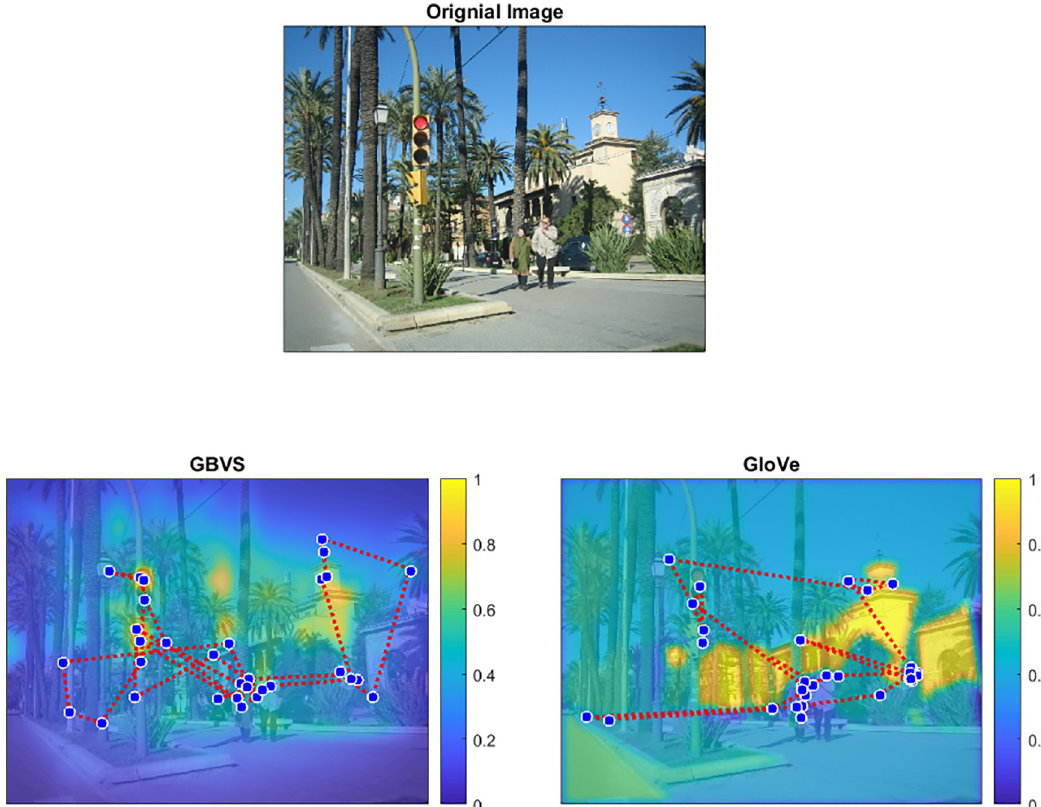
Fig 2. Examples of one image and salience heatmap overlaid with a representative subject’s gaze data. An example image (a) was analyzed with b) low-level image salience and c) high-level semantic salience, see text for details. Areas with yellow values denote higher relevance coded by each model. A Gaussian of 0.375˚ was implemented to smooth the heatmap edges between distinct saliencies. Blue circles represent fixations, red dotted lines represent saccades. Heatmap plots demonstrate representative gaze data from 2 individual subjects during the same